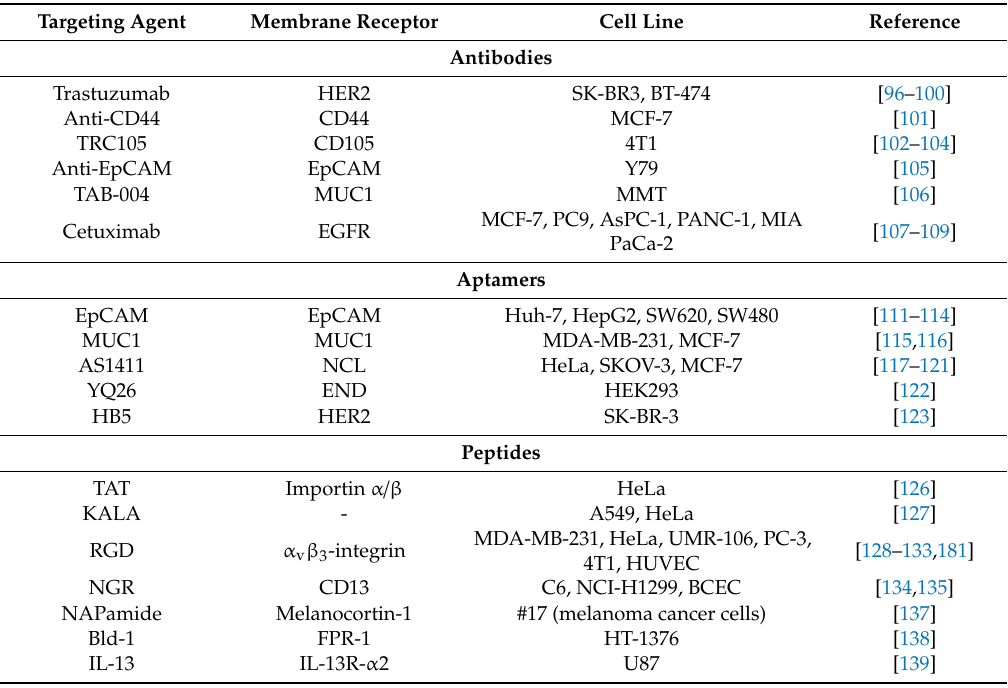
Table 1. Summary of all the targeting agents implemented into